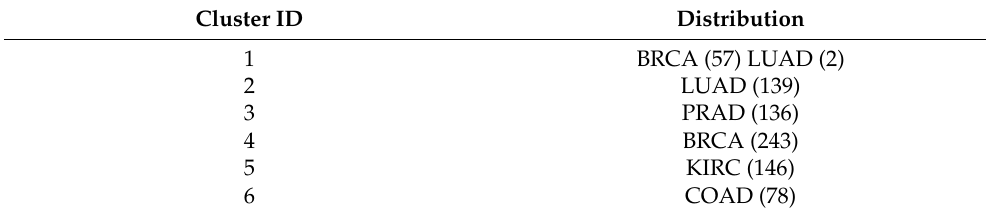
Table 3. The distribution of the MCLUST cluster assignments. The number in parenthesis is the number of subjects for one of the five cancer types.